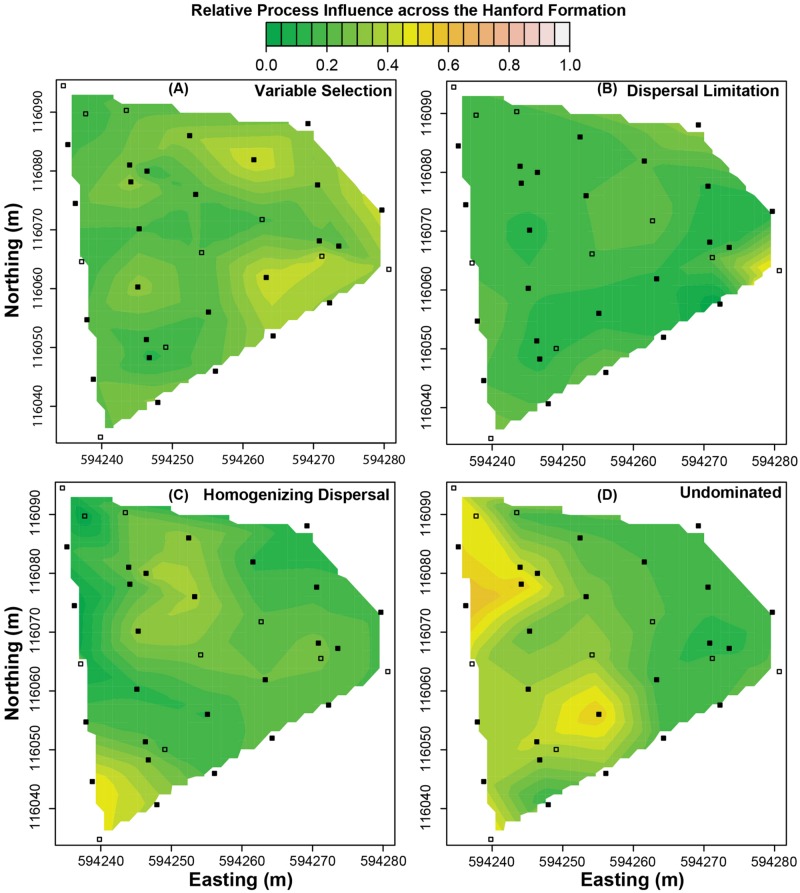
Predicted spatial variation in the relative influences of ecological processes across the Hanford formation. (A) Variable selection, (B) dispersal limitation, (C) homogenizing dispersal, and (D) the undominated fraction. Squares indicate spatial locations where field samples were used to estimate environmental features. Filled squares indicate where field samples were also used to characterize microbial communities. The scale bar applies to all panels.